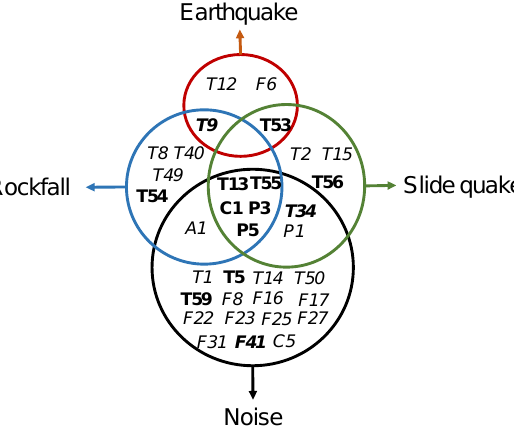
Figure 6. Features that best characterise rockfall, slide quake, earthquake, and environmen- tal/anthropogenic noise. Graph-based feature weight optimisation features in bold, FsLib features in italics, and common features learnt by both graph-based feature weight optimisation and FsLib in bold